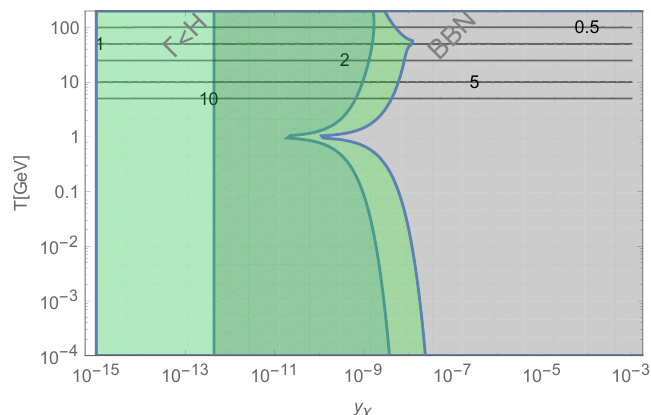
Figure 3 . Decouple conditions bounds on the yukawa of y (cid:31) , the values of z = m (cid:31) =T are shown with solid lines. The Blue and Green regions corresponds to the m N = 20 GeV, m (cid:30) = 110 GeV, m (cid:31) = 50 GeV, ( m (cid:30) > m (cid:31) + m N ) and m (cid:31) = 180( m (cid:31) > m (cid:30) + m N ) respectively. The Gray region are BBN required on the coupling of y (cid:31)